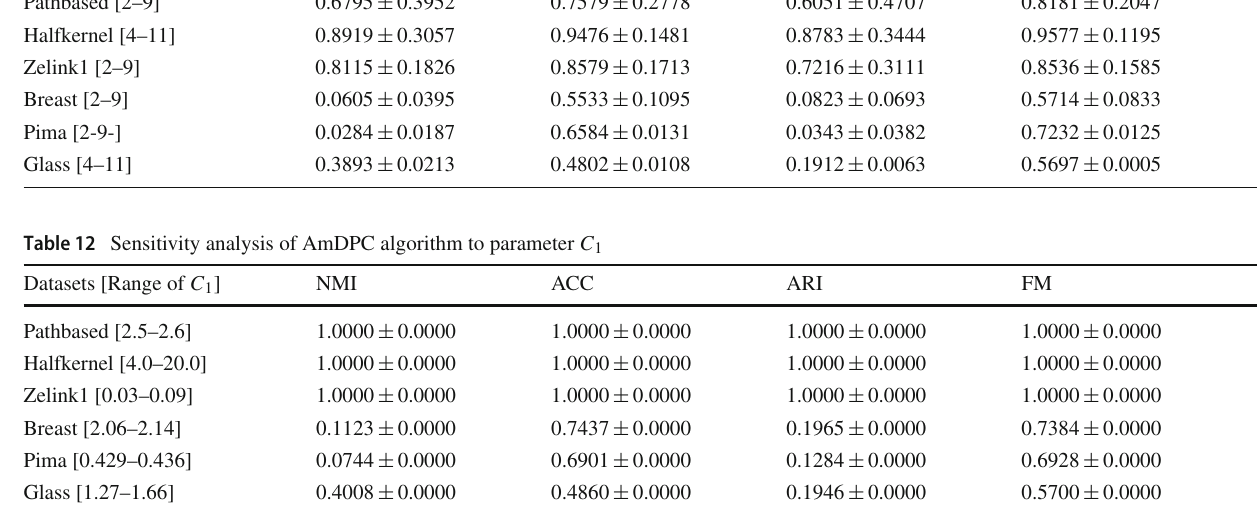
Table 11 Sensitivity analysis of AmDPC algorithm to parameter N i Datasets [Range of N i ]